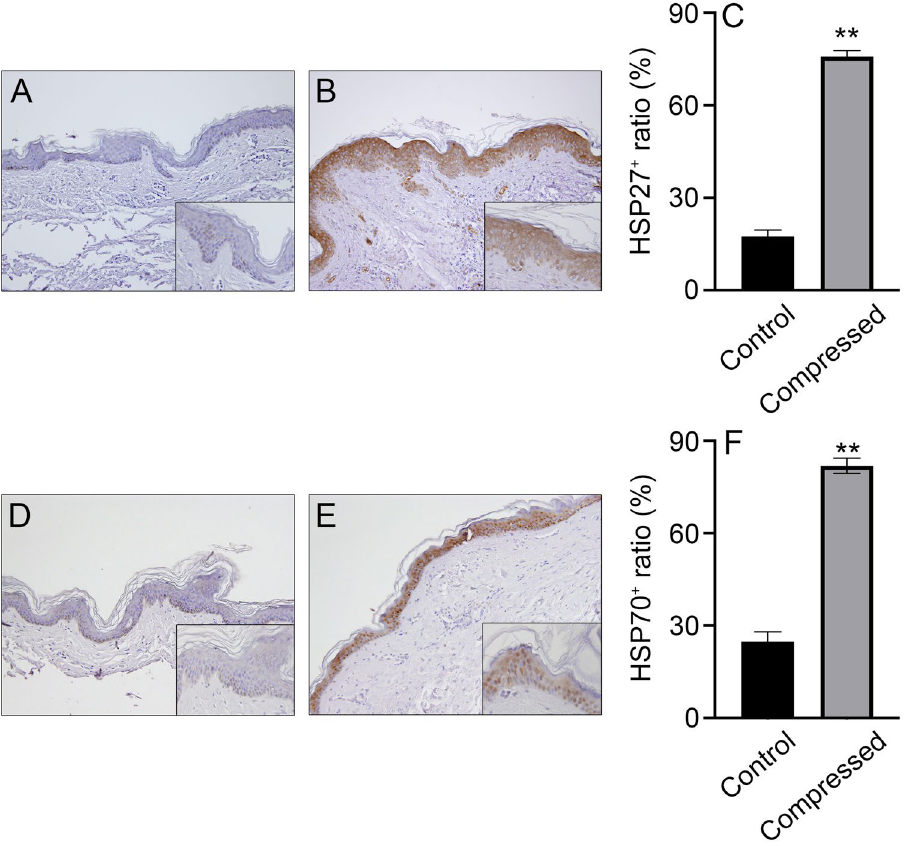
Figure 1. Immunohistochemical analysis. Immunohistochemical analysis were performed by using anti-HSP27 ( A , B ) or anti-HSP70 ( D , E ) mAbs in the human skin samples. ( A , D ) Control; ( B , E ) compressed neck skin. Original magnification, × 200; inset, × 400. ( C , F ) The ratio of HSP27 positives ( C ) and HSP70 positives ( F ) in the corresponding keratinocytes in the skin sample. ** P <